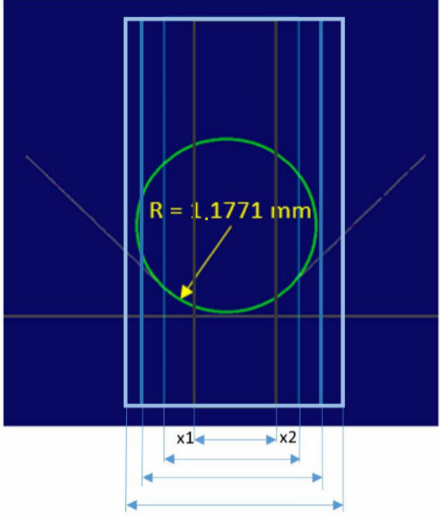
Figure 18. The concept of measurement area width